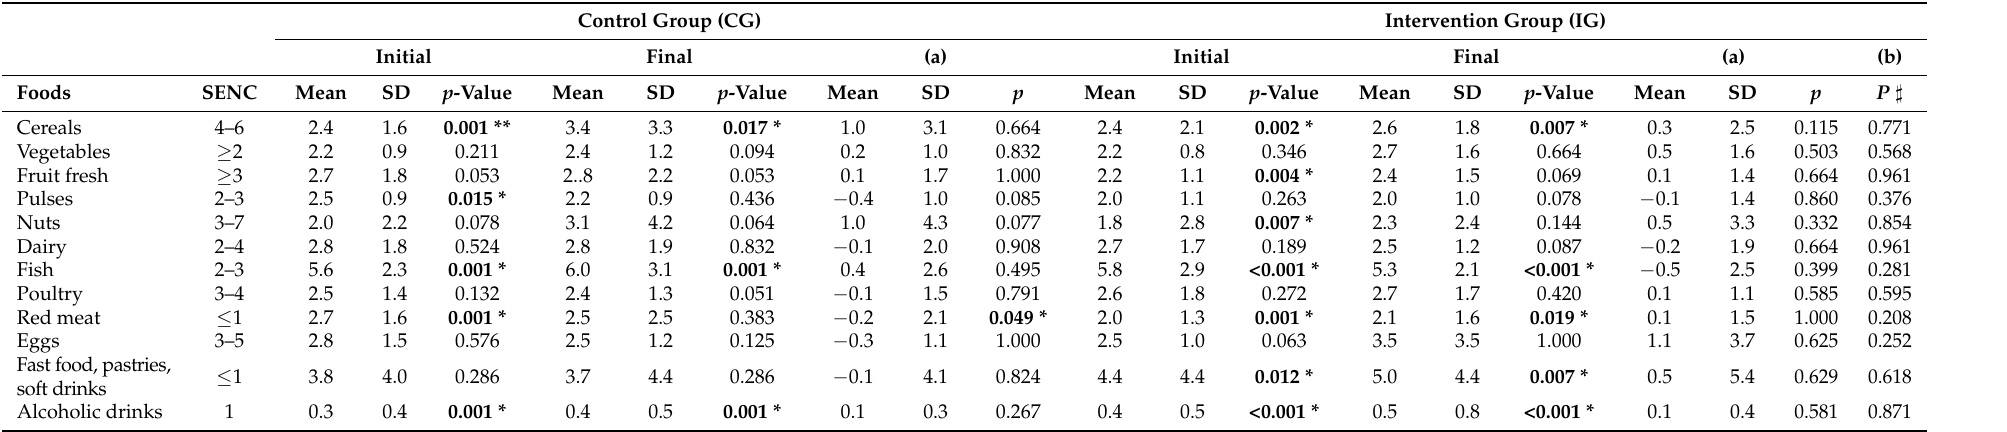
Table 3. Changes from the baseline in the Control Group (CG) and Intervention Group (IG) in food consumption patterns and adequacy of food frequency to the recommendations proposed by the Spanish Society of Community Nutrition